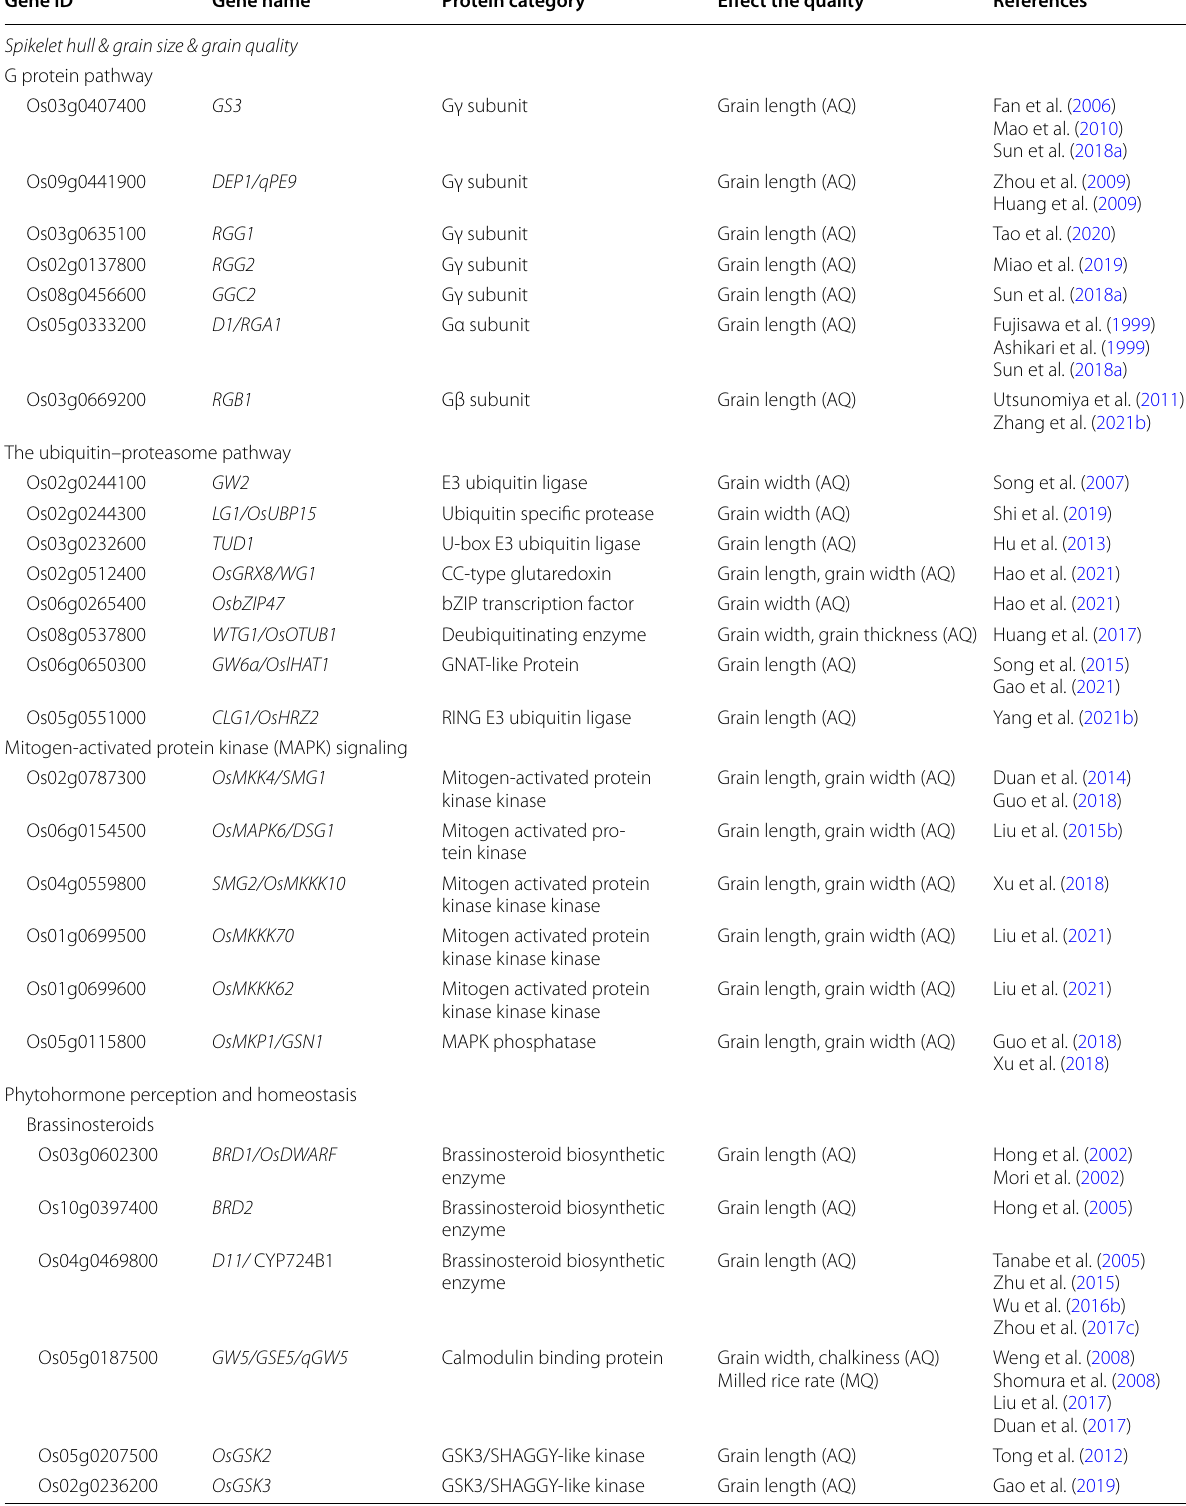
Table 1 List of genes involved in controlling rice seed structures and grain